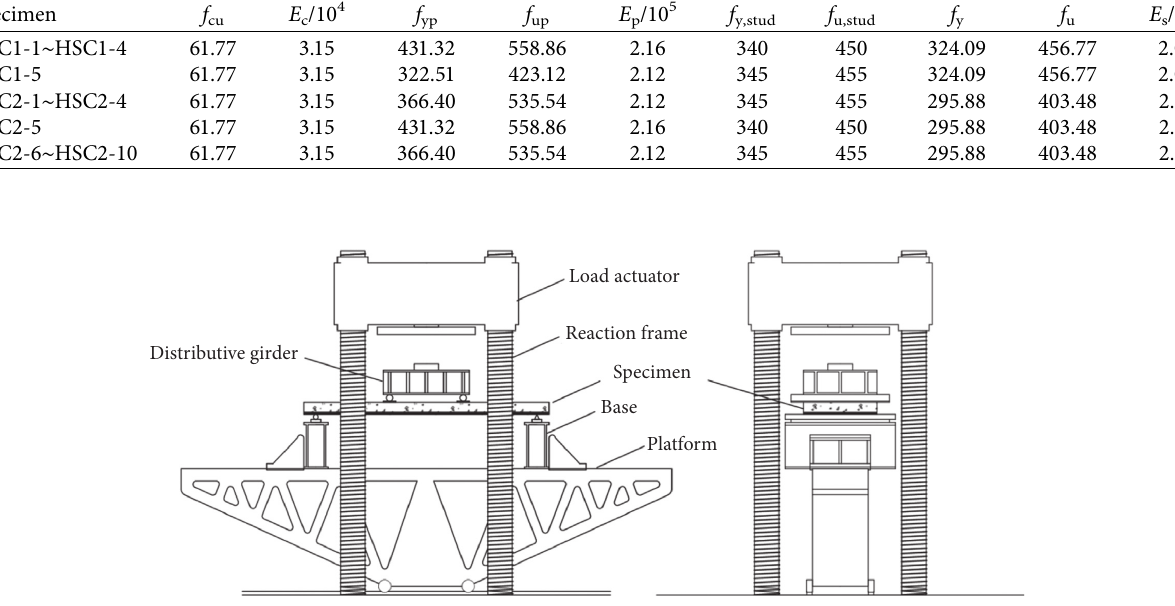
Figure 4: Test device.